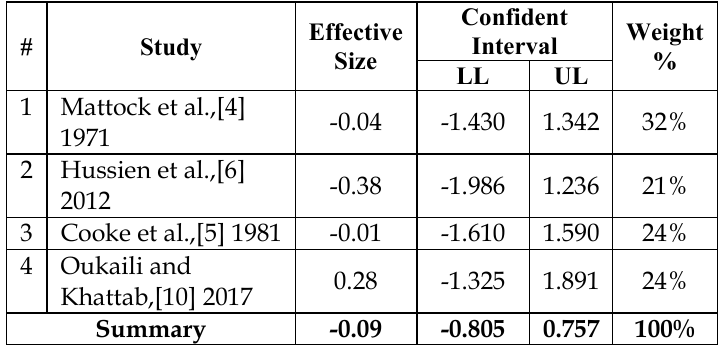
Basic Information.